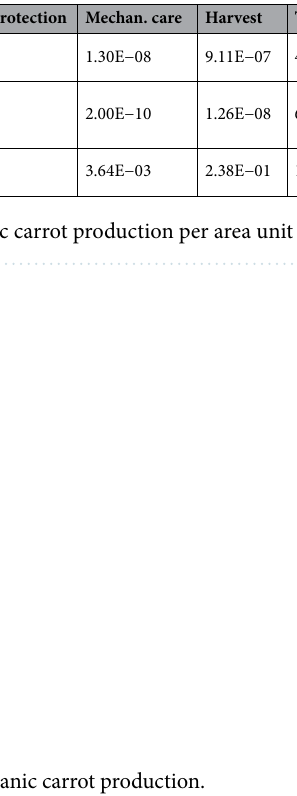
Figure 7. The structure of WF in individual impact categories in organic carrot production.